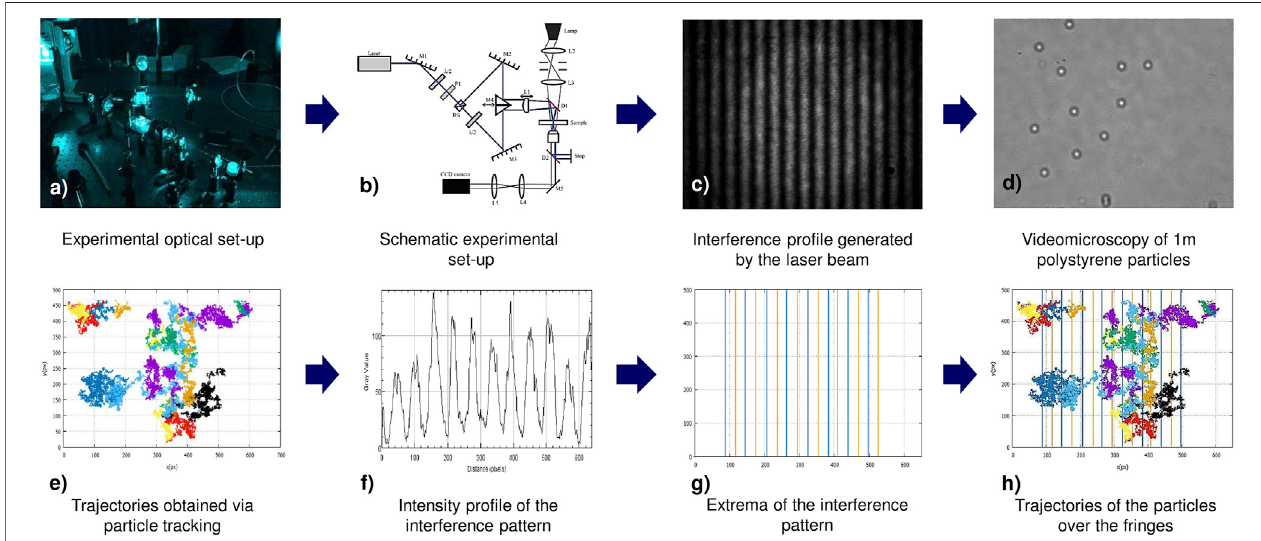
FIGURE 1 | (Color online): Experimental measurement protocol of the dynamic properties of spherical tracers in periodic cosine-like potentials: (A) long exposure photograph showing the light path producing the periodic distribution of light; (B) schematic representation of the experimental set-up; (C) light intensity pro fi le generatedexperimentally; (D) typicalbright fi eldimagesofsphericaltracersinteractingwiththeexternal fi eld; (E) trajectoriesobtainedfromtheexperimentusingTrackpy; (F,G) themaximaandminimaoftheperiodicpotentialsareestimatedfromthebrightanddarkregionsdisplayedinthepanel (C) ;and (H) thedensityofprobabilityis calculated from the information obtained from the trajectories of the particles over the